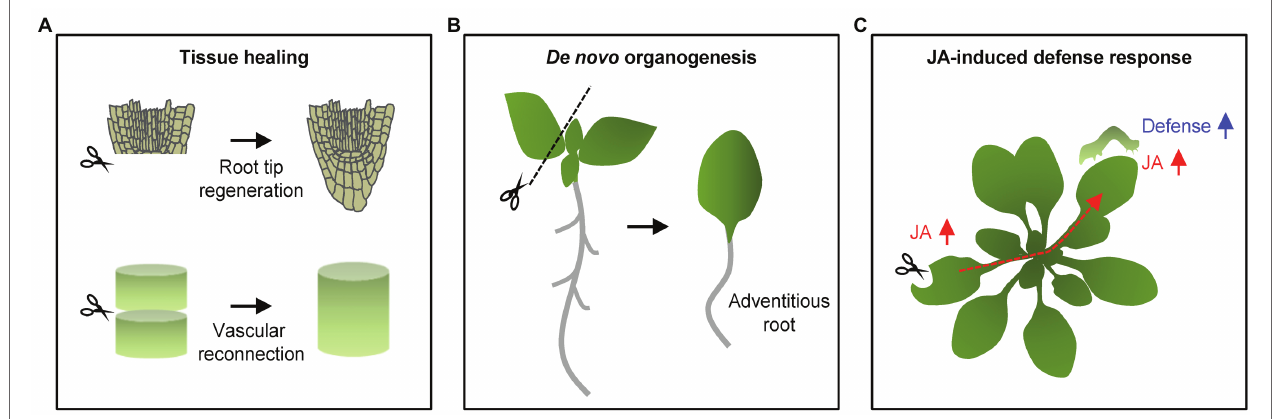
FIGURE 1 | Wound-induced local and systemic responses in plants. (A) Wound healing and tissue regeneration. Upon wounding, plants stimulate wound healing and tissue regeneration. Excision of the root apical meristem and vascular tissues leads to the tissue restoration in local damaged regions. (B) Wound-induced adventitious root formation. Wounding occasionally results in cell fate changes as shown by the adventitious root formation from detached leaf explants. (C) Wound- induced defense responses. Wounding also increases defense capacity in both local and systemic tissues. Jasmonic acid (JA) is a pivotal phytohormone stimulating plant defense responses not only in damaged local tissues, but also distal plant organs. Long-distance signals propagate through vasculatures in order to confer systemic defense resistance in a whole